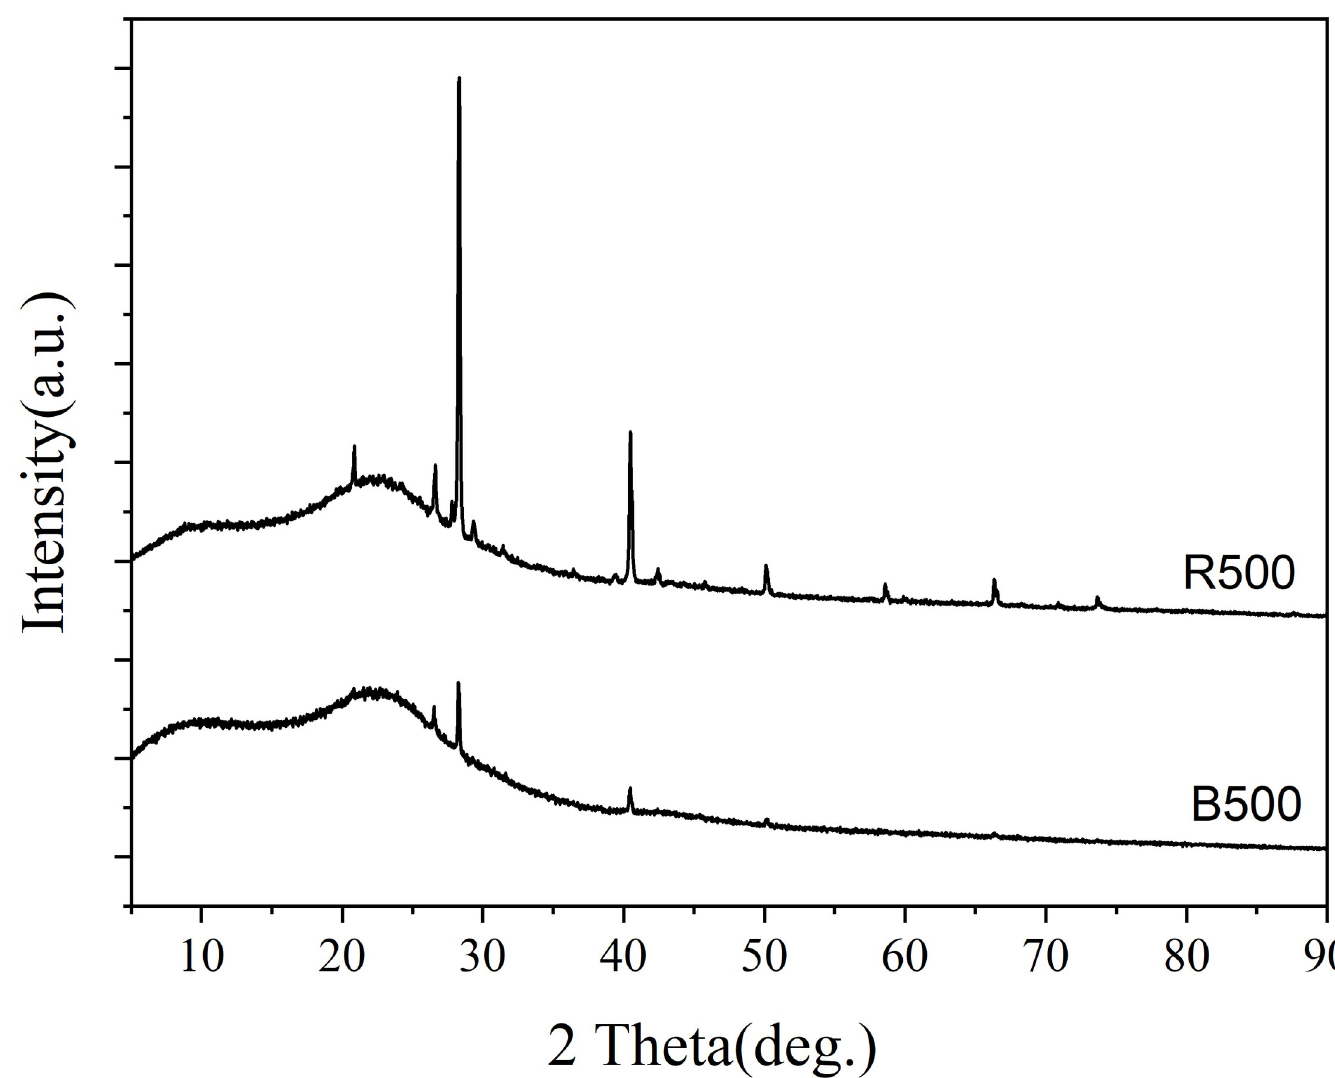
Fig 2. X-ray diffraction patterns of bamboo and rice straw biochar produced at 500˚C.